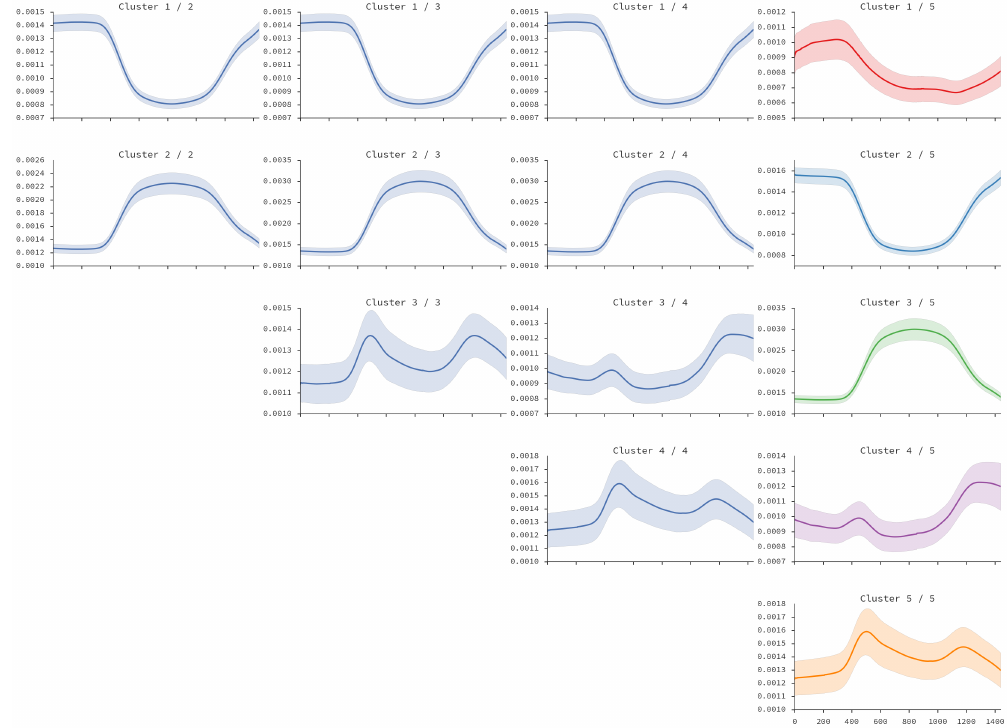
Figure 14. Clusters obtained from the analysis of district dynamic population.